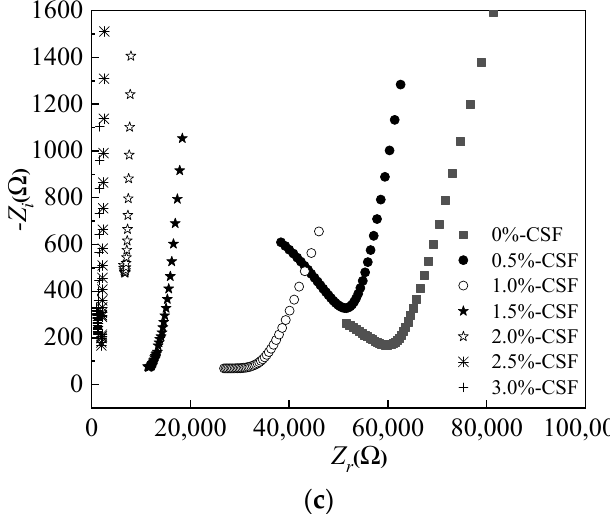
Figure 16. AC impedance spectrum curves of reinforced MPC-RPC. ( a ) Before corrosion. ( b ) After 300 NaCl F-T cycles. ( c ) After 30 NaCl D-W alternations.